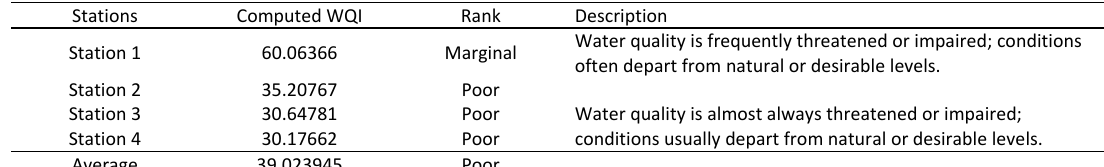
Table 4: Computed WQI in each station